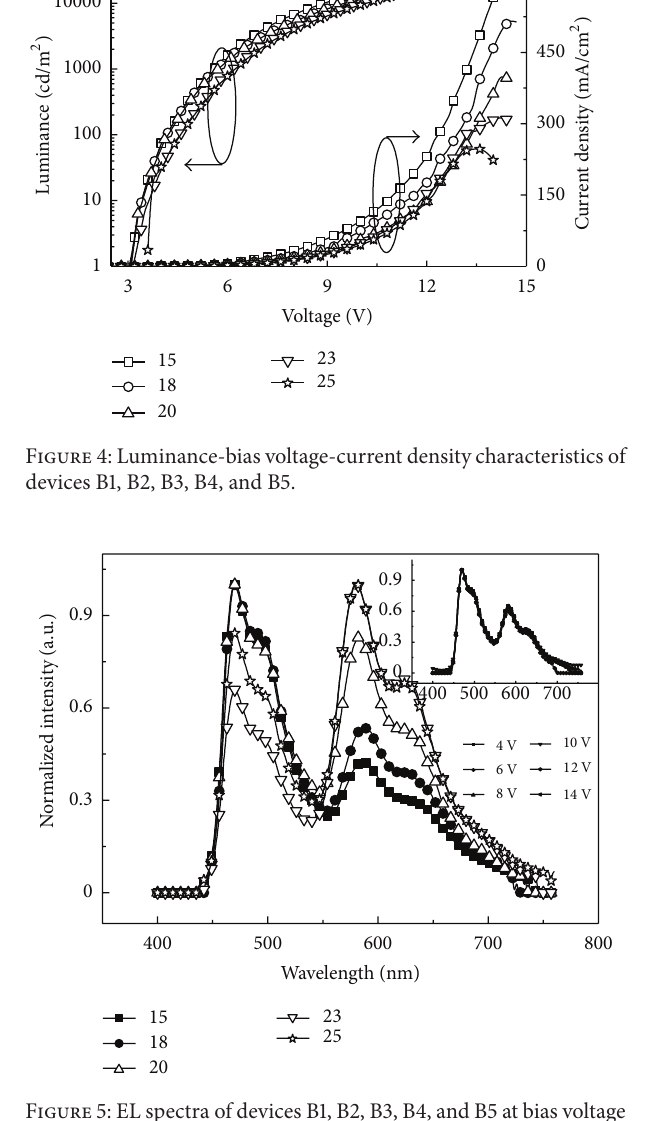
Figure 5: EL spectra of devices B1, B2, B3, B4, and B5 at bias voltage of 8V. Inset: EL spectra of device B3 driven by different bias voltages.